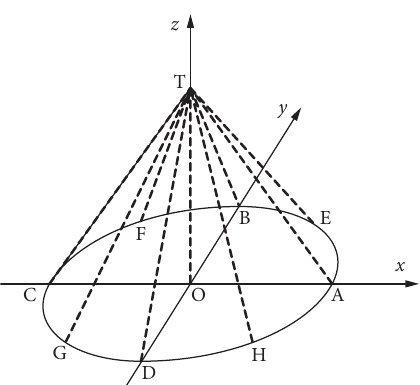
Figure 4: The stress field constructed by 9 stress